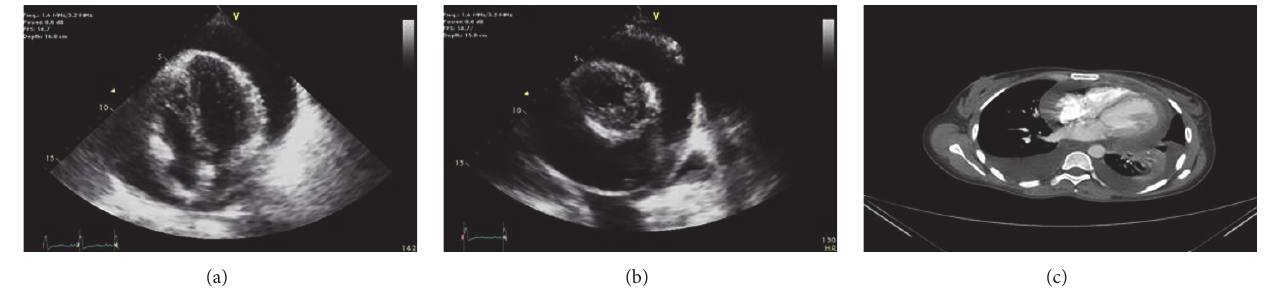
Figure 1: Transthoracic echocardiography demonstrates a large pericardial effusion ((a) apical 4-chamber view and (b) parasternal short axis view) and chest CT shows a large pericardial effusion, bilateral pleural effusions, and atelectasis of the left lower lobe (c).